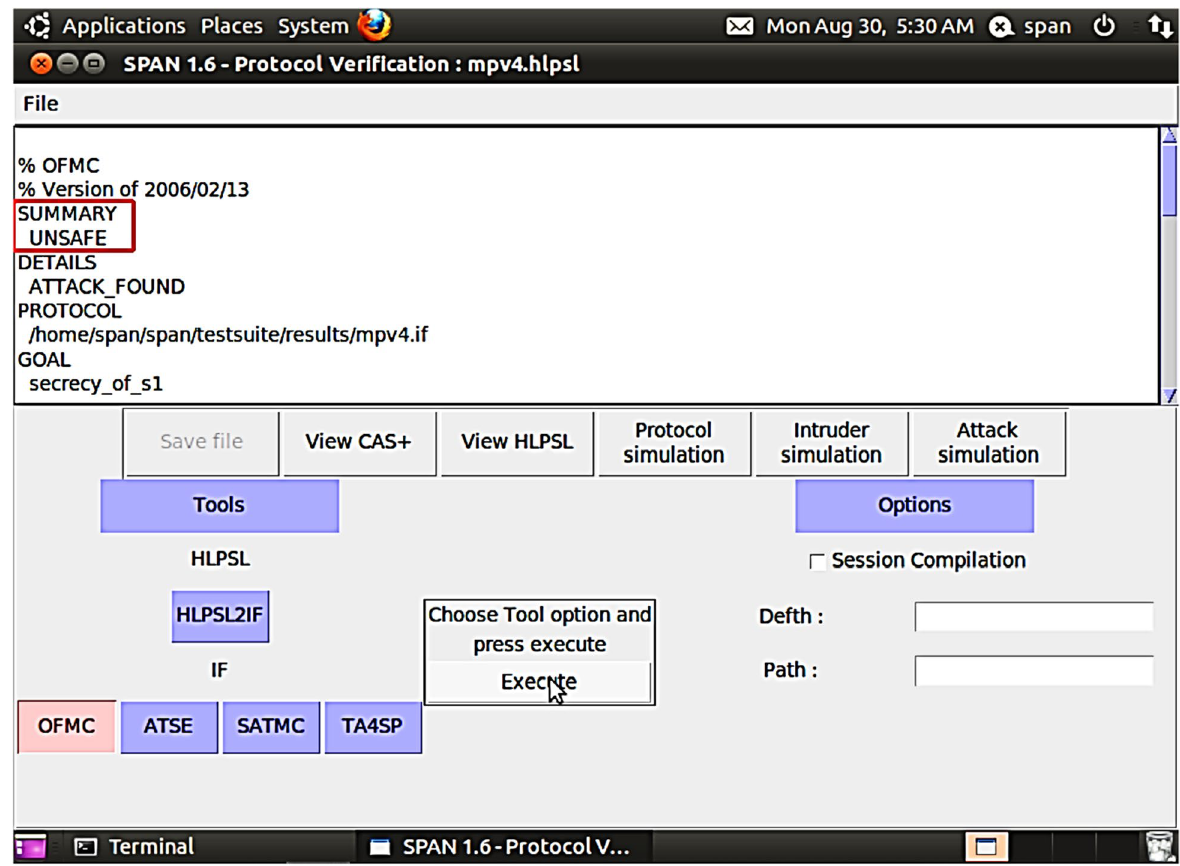
Fig. 9 Traditional authentication protocol analysis